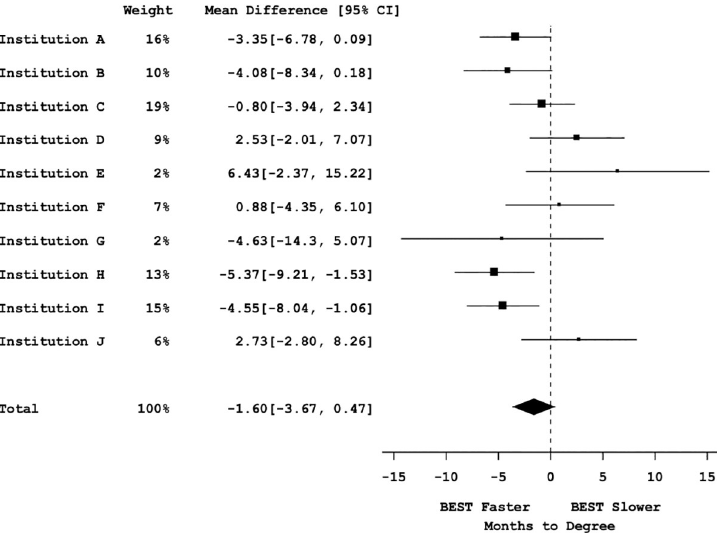
Fig 2. Graduate student efficiency measured by time to degree vs. bivariate participation. Mega-analysis forest plot displaying mean effect sizes (squares) and confidence intervals (brackets) for effect sizes of time to degree vs. bivariate professional development participation (control vs. participants). Large squares denote greater impact on the effect size based on sample size and effect size in each institutional sample. The vertical dotted line represents a null effect. The size and shape of the diamond at the bottom of the forest plot represent the effect size. Because the diamond overlaps the vertical line (null effect), this indicates that the effect of professional development participation on time to degree is not significant. See Table H in S1 Text for statistical results. All data sets are available at https://osf.io/qy3pa/ (permanent DOI: 10.17605/OSF.IO/QY3PA; see also [33]). BEST, Broadening Experiences in Scientific Training.